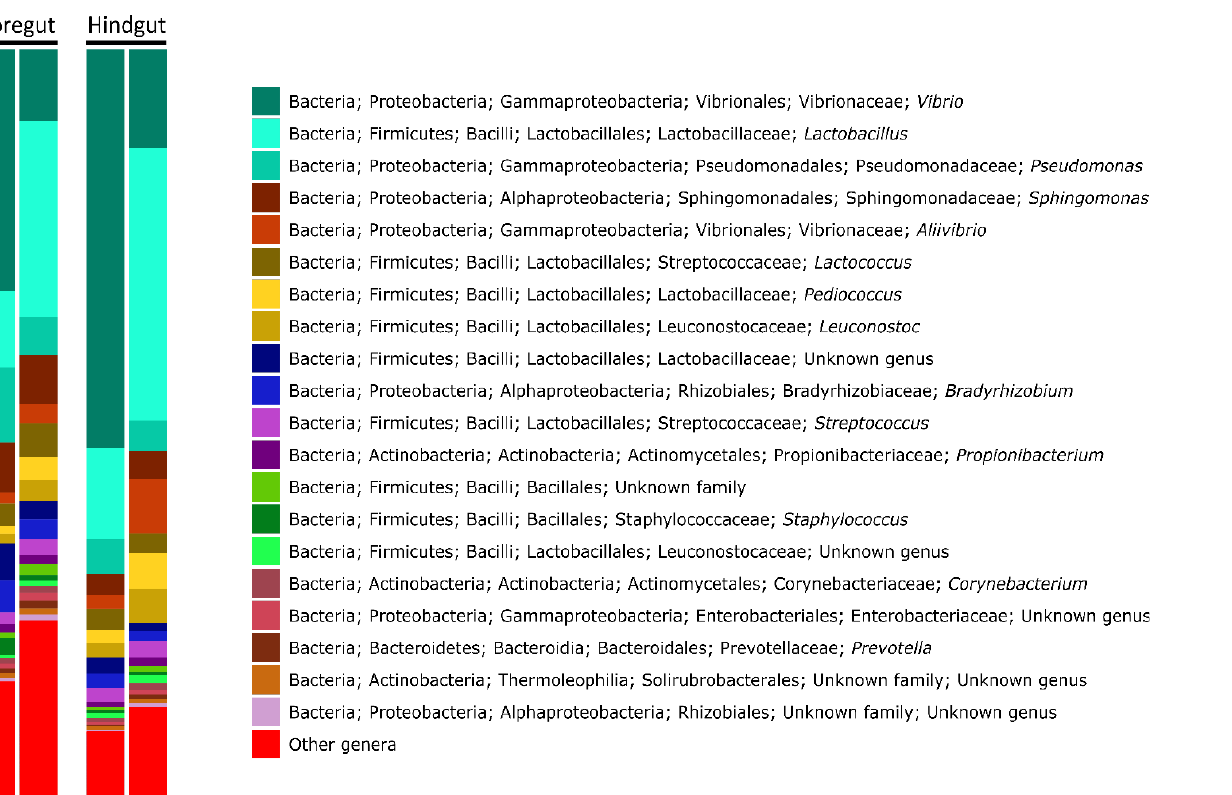
Figure 2 . Bar plot summarizing the relative bacterial abundance at the genus level in different gut regions (foregut and hindgut) and treatments. Control (C) refers to gilthead seabream juveniles fed with basal diet while Allium -derived PTSO (T) refers to experimental gilthead seabream juveniles fed with basal diet supplemented with Allium -derived PTSO. Sample size was 48 for control foregut, 55 for control hindgut, 42 for Allium -supplemented foregut, and 51 for Allium -supplemented hindgut.